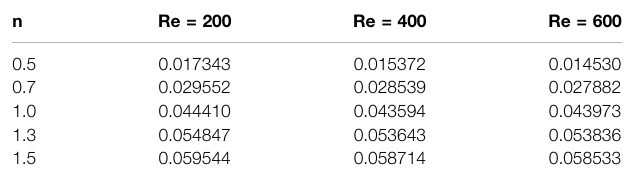
TABLE 2 | Impact of n on the kinetic energy for different values of Re .